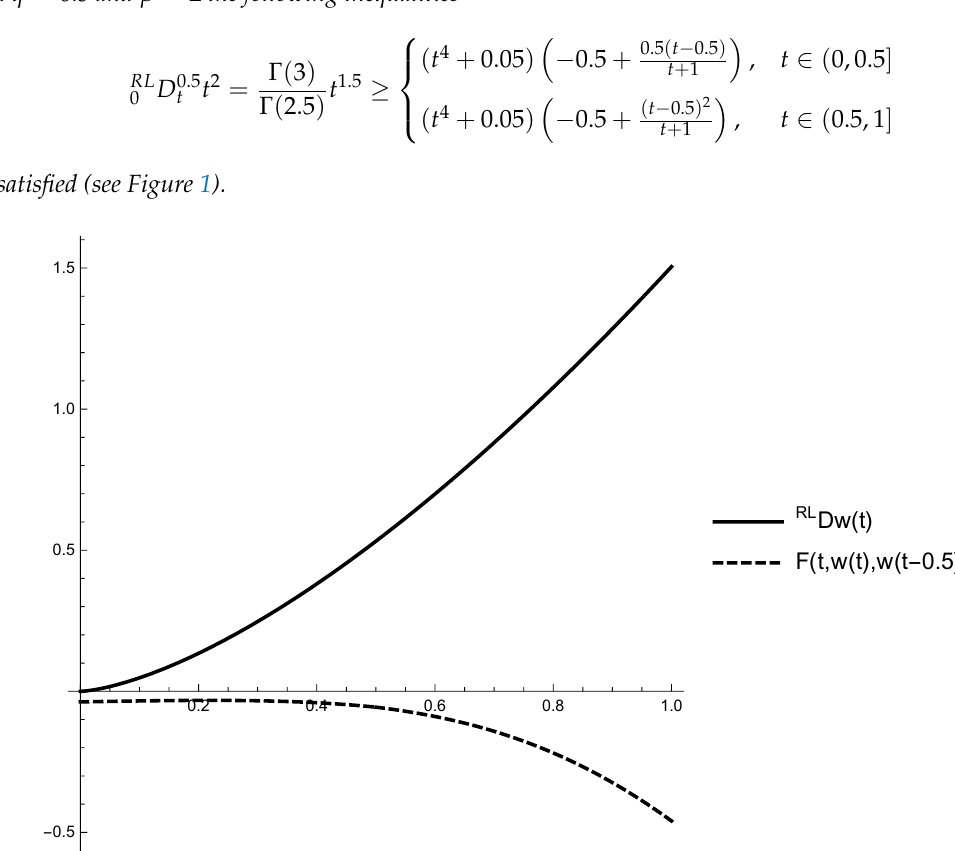
Figure 1. Graphs of the fractional derivative of the function w ( t ) and the right side part of the equation on [ 0,1 ]